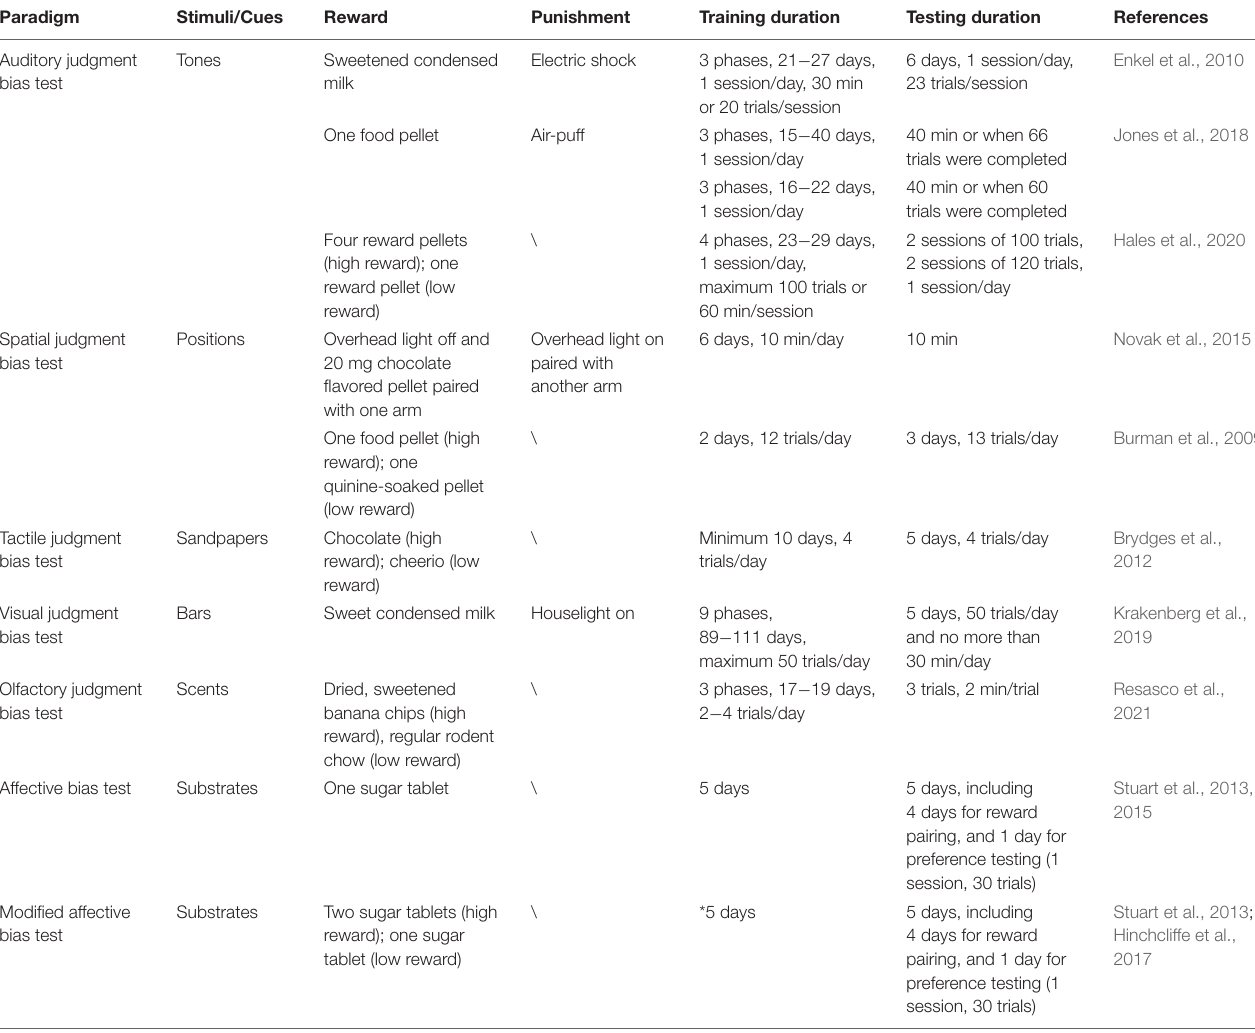
TABLE 1 | Some methodological details of representative cognitive bias